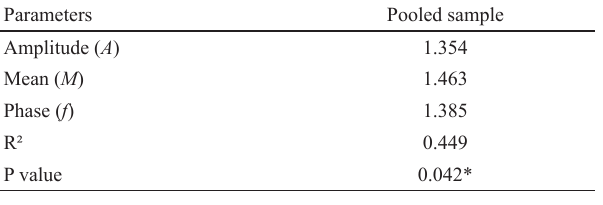
Tab. 2. Parameters of the sinusoidal equation for the Gonadossomatic Index (GSI) values recorded for the red- tailed catfish, Phractocephalus hemioliopterus , specimens collected from the Xingu River in Pará, Brazil. *indicates a seasonal trend in the curve.